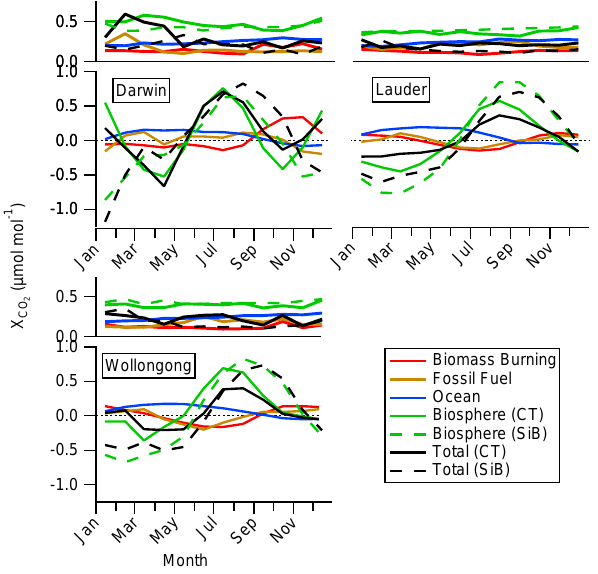
Figure 4. Mean seasonal cycles (bottom panels) and interannual variability (top panels) in the CT2011_oi simulation for the South- ern Hemisphere TCCON sites Darwin (top left), Wollongong (bot- tom) and Lauder (top right), decomposed by source process: total (black), biomass burning (red), ocean (blue), terrestrial biosphere (green) and fossil fuel (brown). The MSC for the SiB terrestrial bio- sphere is also shown in dashed green. For each site the magnitude of the interannual variability is derived from the standard deviation in the derived MSC.